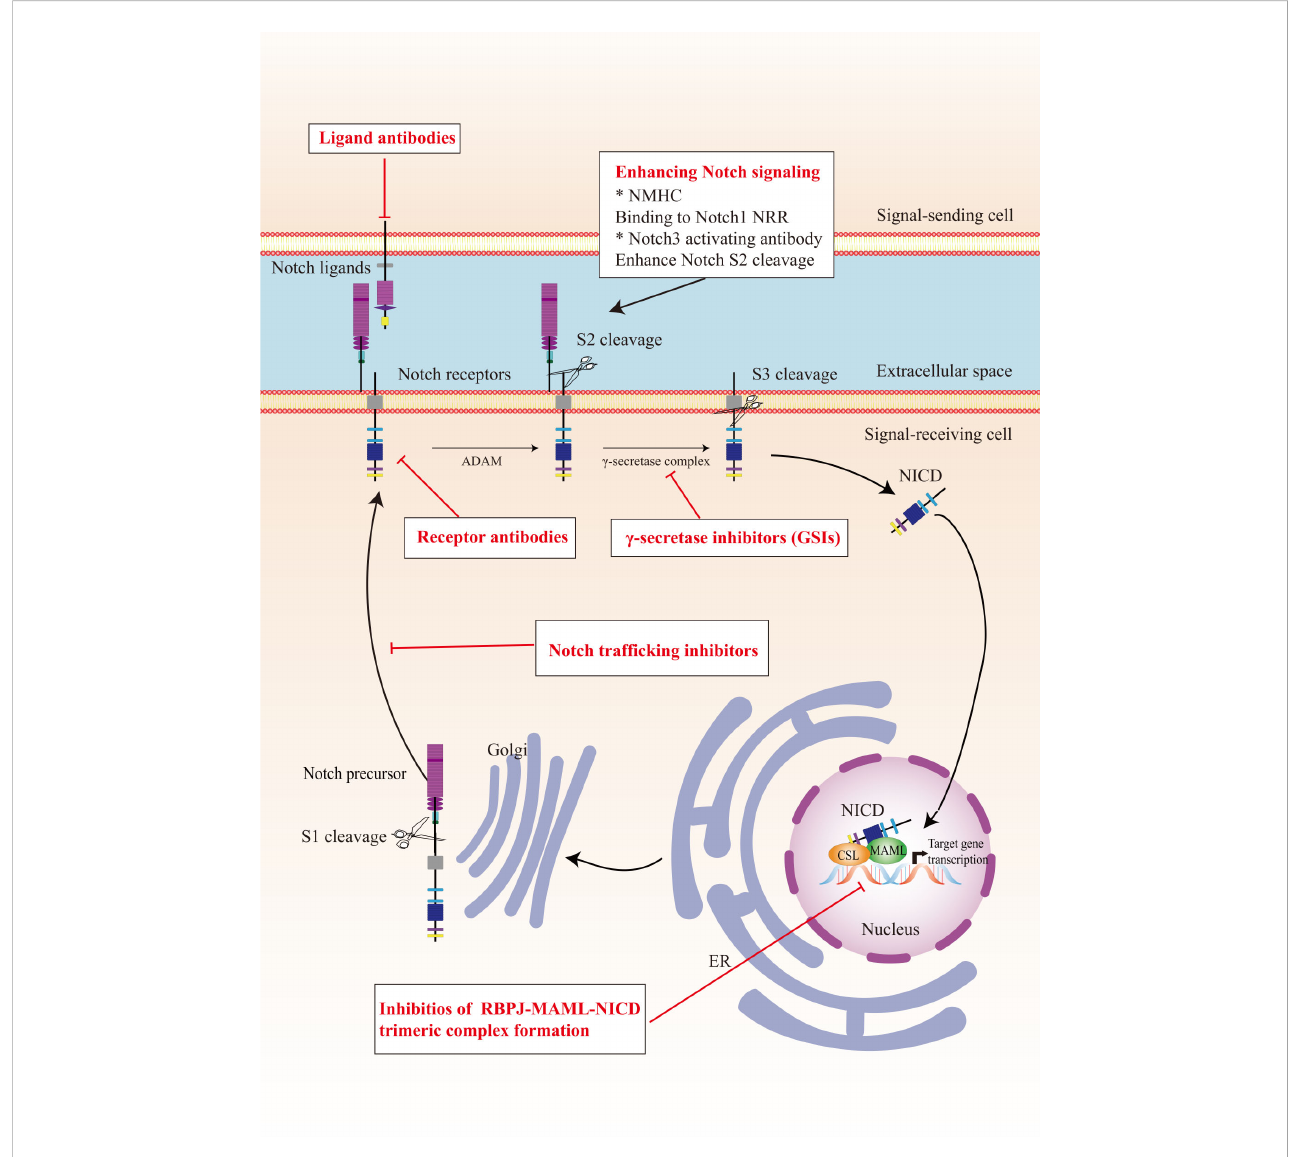
FIGURE 3 The potential therapeutics targeting Notch signaling pathway. Here are several strategies to modulate Notch signaling pathway: (I) inhibitors of Notch pre-processing, (II) receptor and ligand antibodies blocking ligand-receptor interaction, (III) inhibitors of the trimeric transcriptional complex assembly, (IV) molecules activating Notch signaling. ER, endoplasmic reticulum; NICD, Notch intracellular domain; NRR, negative regulatory region; NMHC, N- methylhemeanthidine chloride; MAML, Mastermind like transcriptional coactivator; GSIs, g -secretase